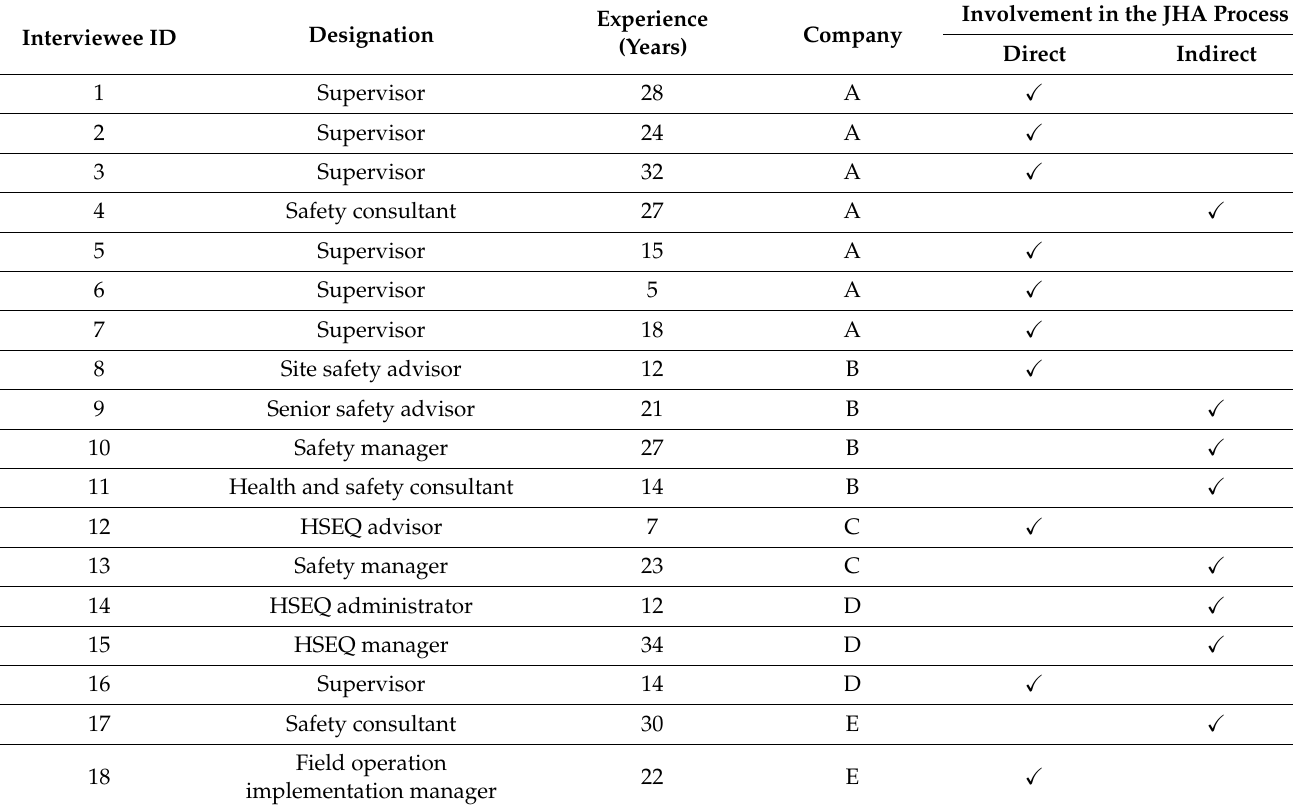
Table 3. Interviewee